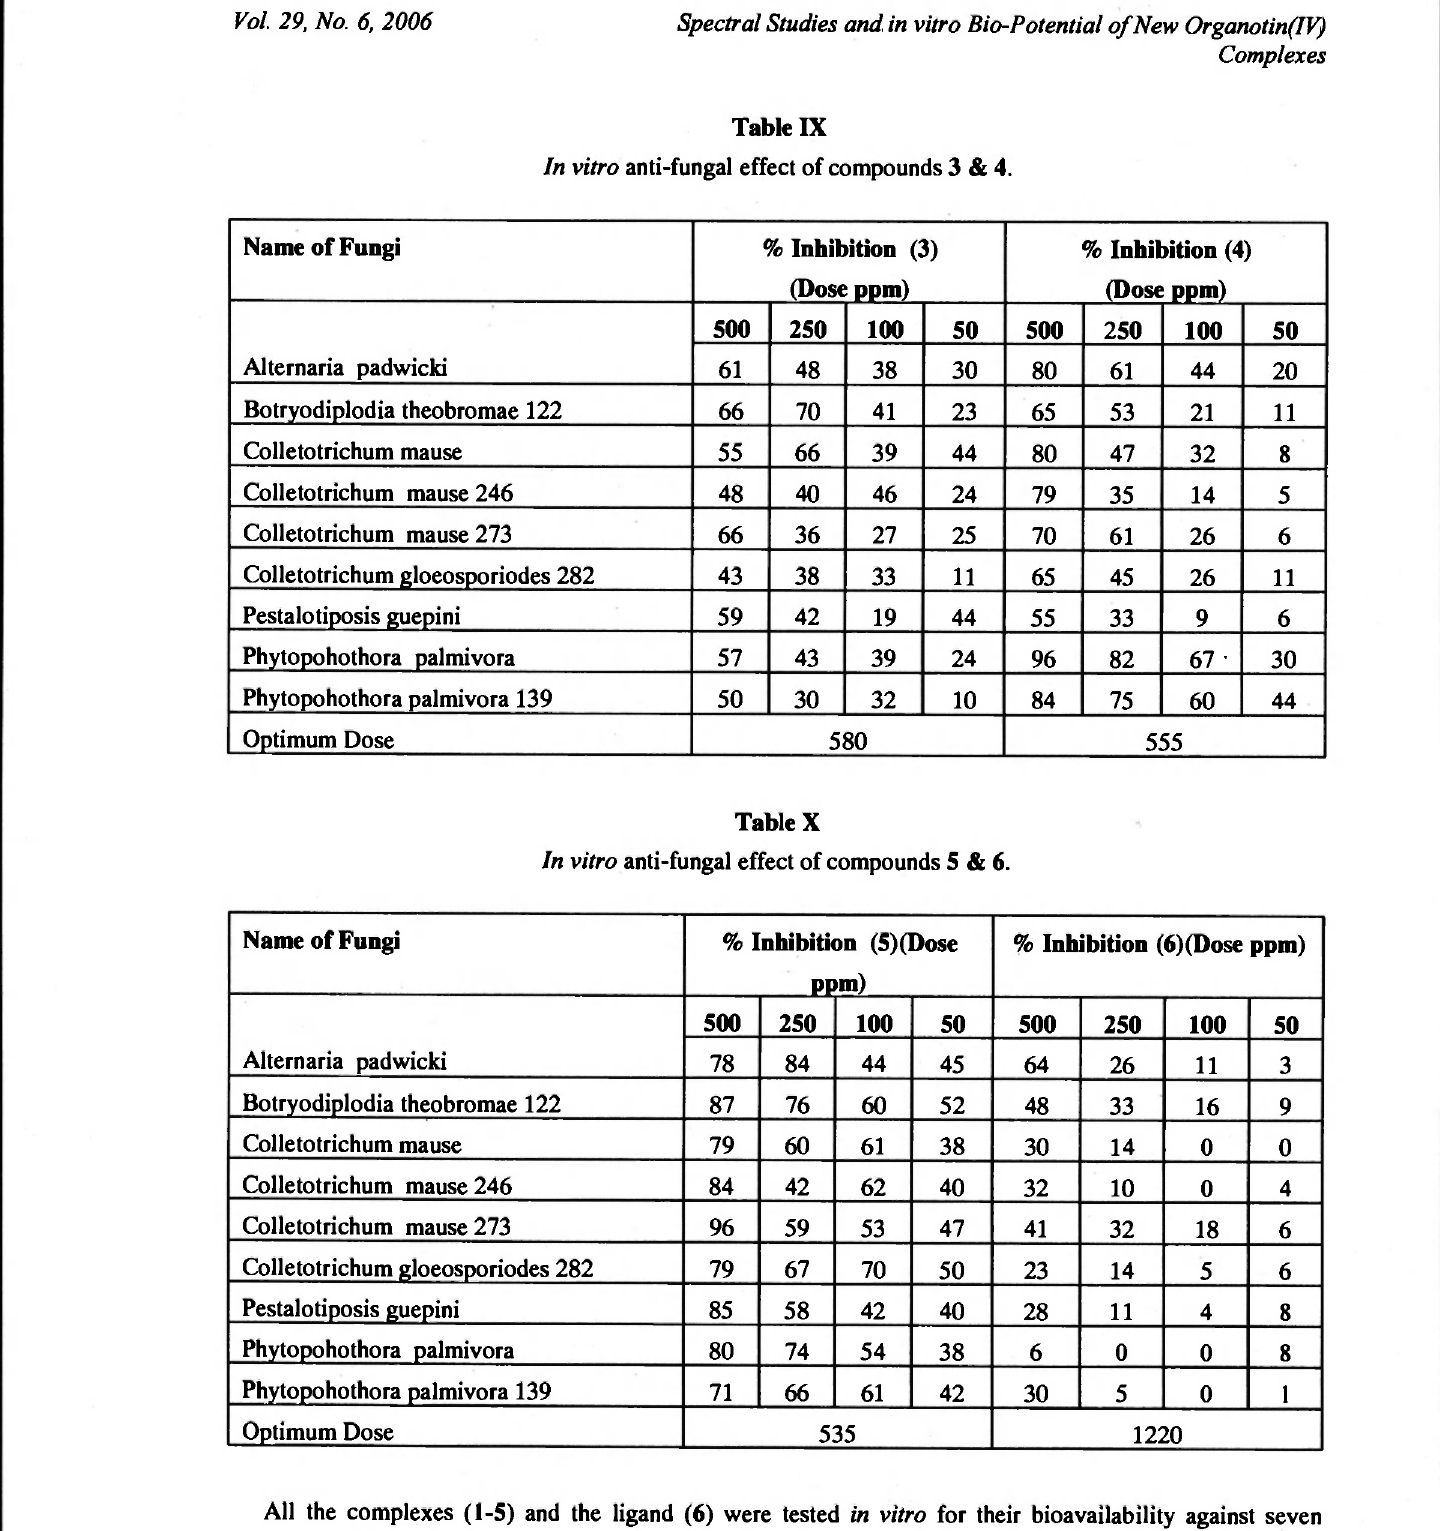
In vitro anti-fungal effect of compounds 3 & 4.